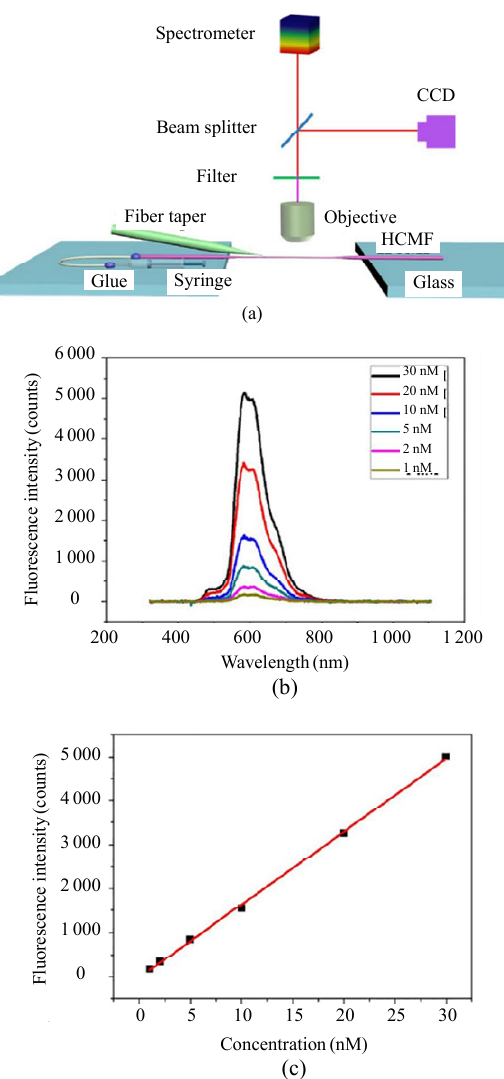
Fig. 12 Frequency-based microfiber fluorescence sensor: (a) scheme of the experimental setup for a hollow-core-microfiber-based fluorescence